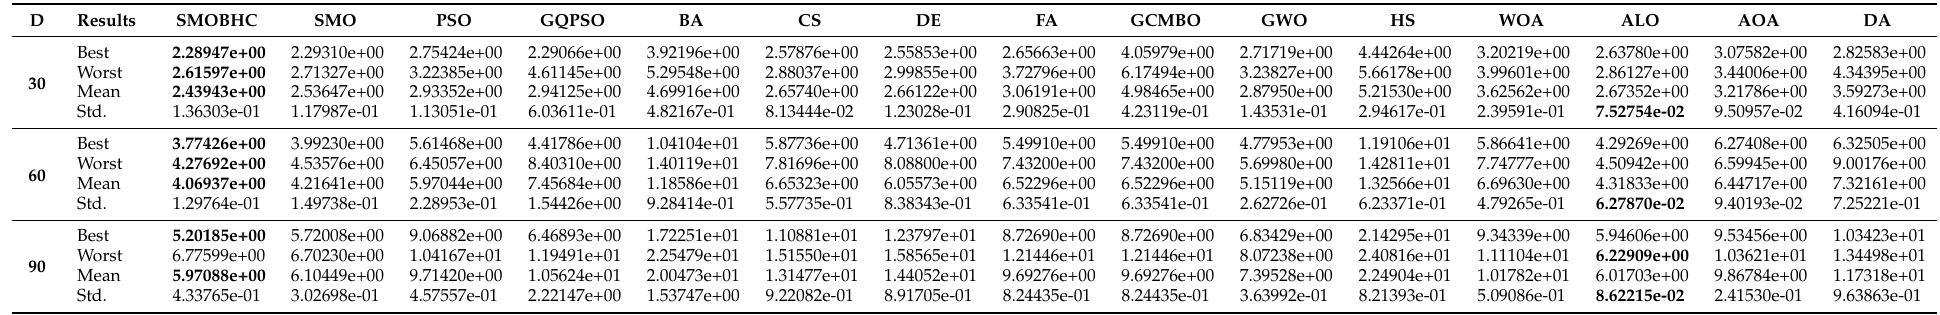
Table 3. Experimental results obtained for the fifteen experimented algorithms relative to three different problem dimensions equal respectively to 30, 60, and 90 for the first battlefield composed of ten threats.